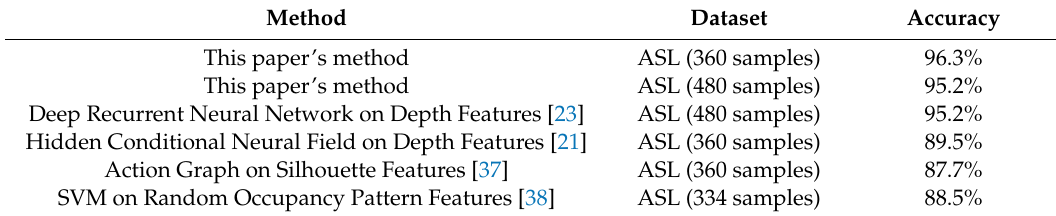
Table 6. Comparison of the accuracy among significant works on the ASL